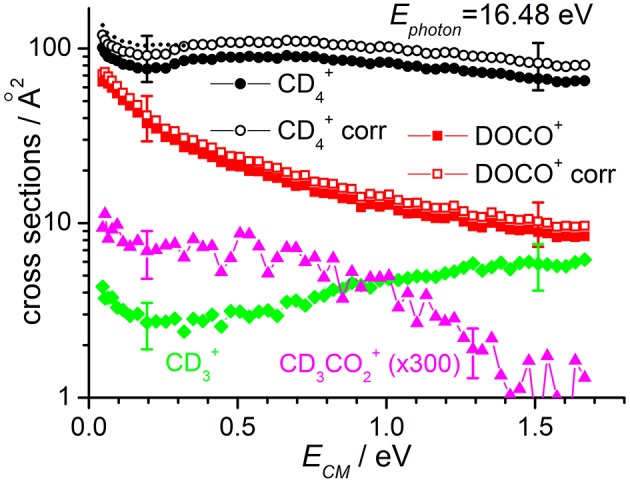
Reactive cross sections for products CD4+ (uncorrected, black circles), DOCO+ (uncorrected, red squares), CD3+ (green diamonds), and CD3CO2+ (magenta triangles) measured as a function of the collision energy (ECM) in the DC mode at a photon energy Ephot = 16.48 eV. The open black circles and open red squares are the CD4+ and DOCO+ cross sections corrected to include the contribution of secondary reactions leading to CD5+ (data not shown). The dotted line represents the CD4+ cross sections corrected for the instrumental effect due to decreased collection efficiency at low ECM (see text for details). Error bars on all the data are about 30%: for the sake of clarity only two error bars are reported, at arbitrarily chosen low and high collision energy values.